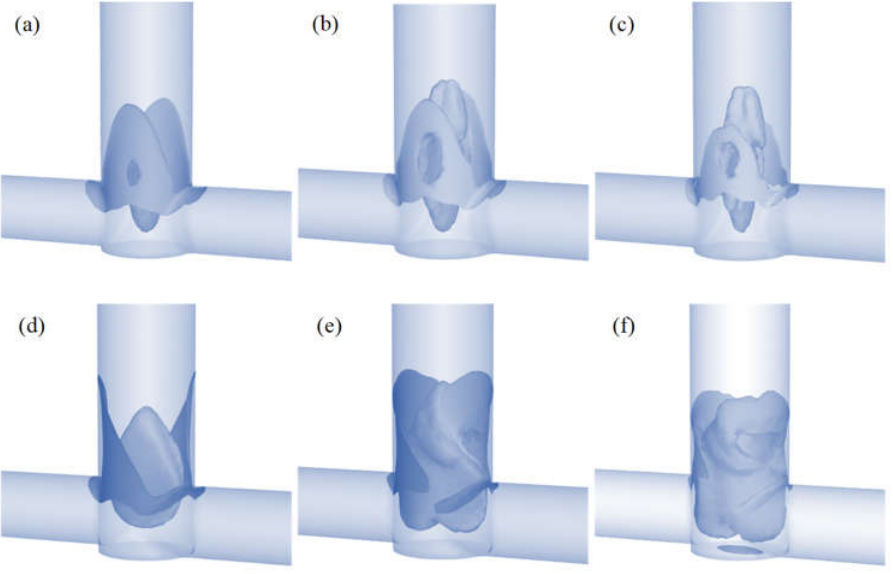
Figure 6. Mixing zones with turbulence intensity above 70% in the T-reactor for various flow velocities of CA ( a ) 20, ( b ) 40, and ( c ) 60 mL/min and in the S-reactor for ( d ) 20, ( e ) 40, and ( f ) 60 mL/min.